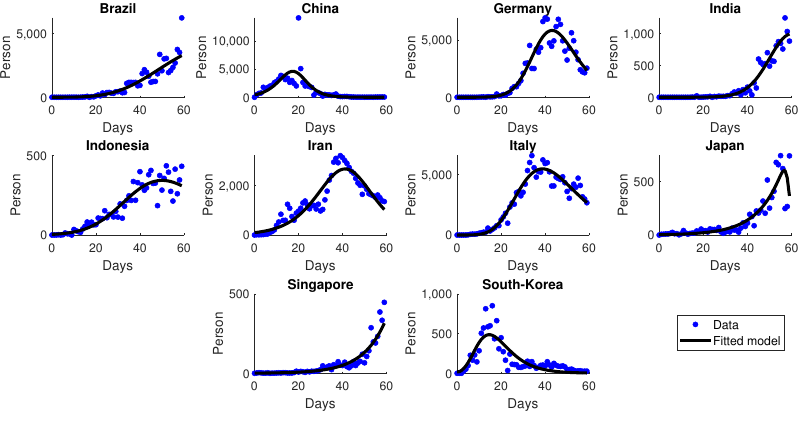
Figure 5. Simulation results of daily new cases γ T 1 ( ¯ K ) for several countries in the early pandemic. Blue dots represent the actual data, and the solid black lines represent the simulation.